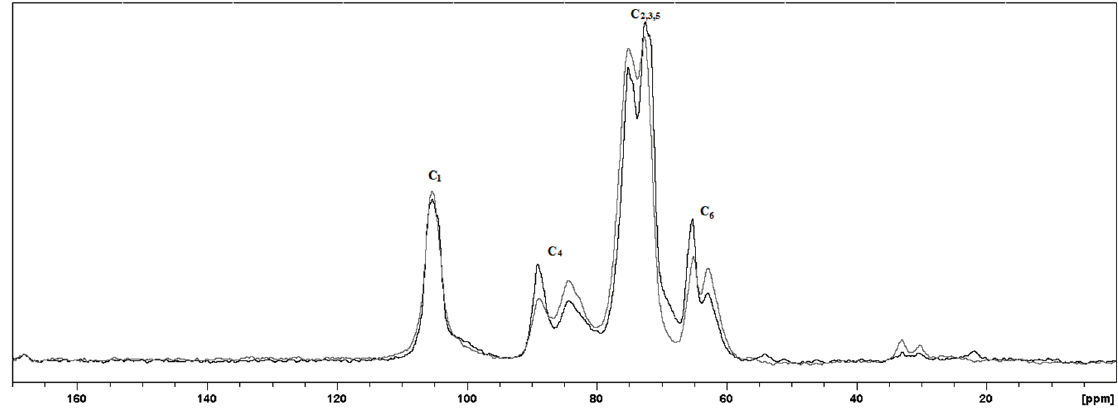
Figure 5. CP/MAS NMR spectra of nanocellulosic fibers obtained from Citrus-waste Biomass (CB) that was enzymatically treated for 48 h at 45 °C (black) and from chemically treated CB (delignification and bleaching at 120 °C;